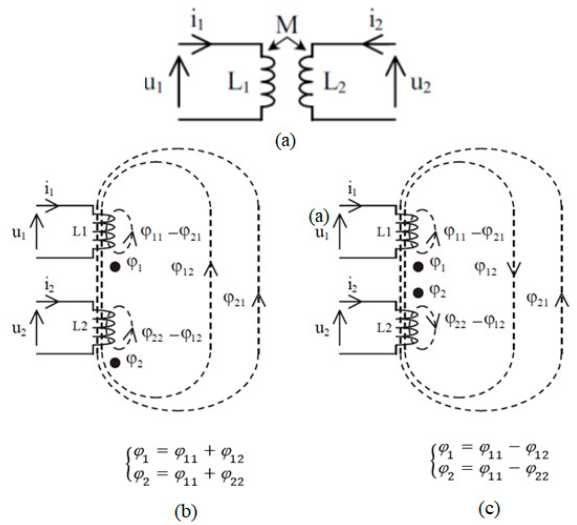
Figure 7. ( a ) Coupled inductor, ( b ) added flux, ( c ) subtracted flux.